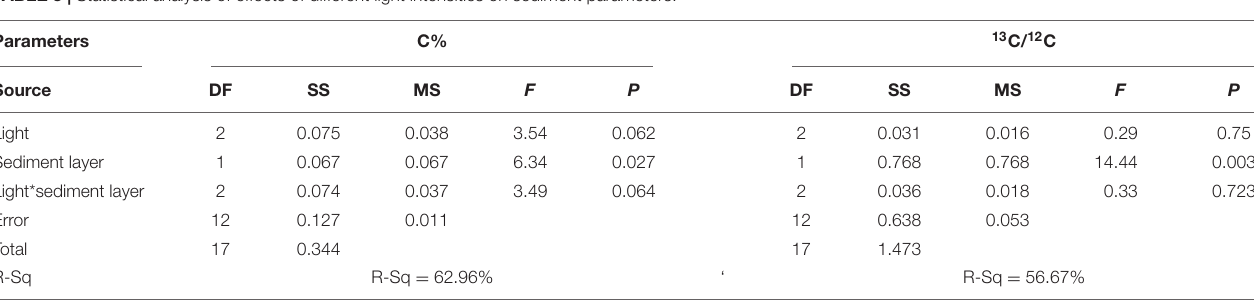
FIGURE 8 | Response of sediment carbon to light treatments. Saturating light: SL, 200 µ mol photons/m 2 /s; low light: LL, 20 µ mol photons/m 2 /s; high light: HL, 600 µ mol photons/m 2 /s. SL and HL were in the optimal light range between the minimum saturating light and the minimum inhibiting light. Different letters on the bars indicate mean values for a particular light condition that significantly differed at ( p < 0.05) (Mean ± SD, n = 3) analyzed by two-way ANOVA. TABLE 3 | Statistical analysis of effects of different light intensities on sediment